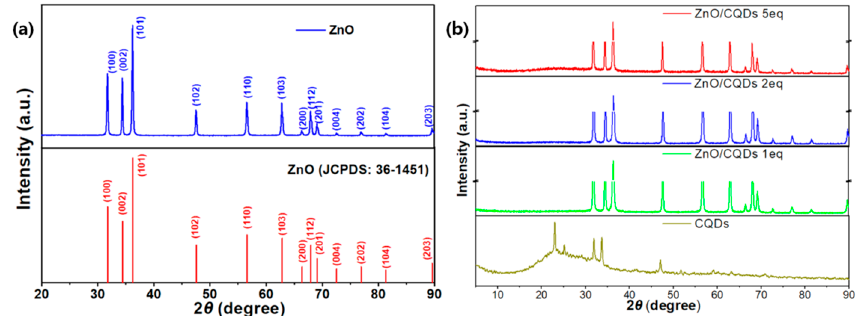
Figure 2. XRD pattern of ( a ) the as-prepared ZnO microspheres; ( b ) the carbon quantum dots (CQDs) and the ZnO/CQDs 1eq (2 eq, 5 eq) composite.